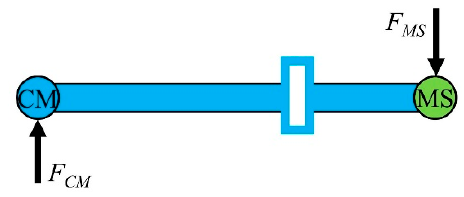
Figure 6. Force analysis of the moving plate.